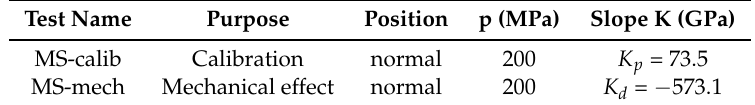
Figure 11. Membrane type sensor: ( a ) interstitial pore pressure calibration test; and ( b ) confining pressure calibration test. Table 4. Description of the MS calibration test: condition, pressure applied and curve slope